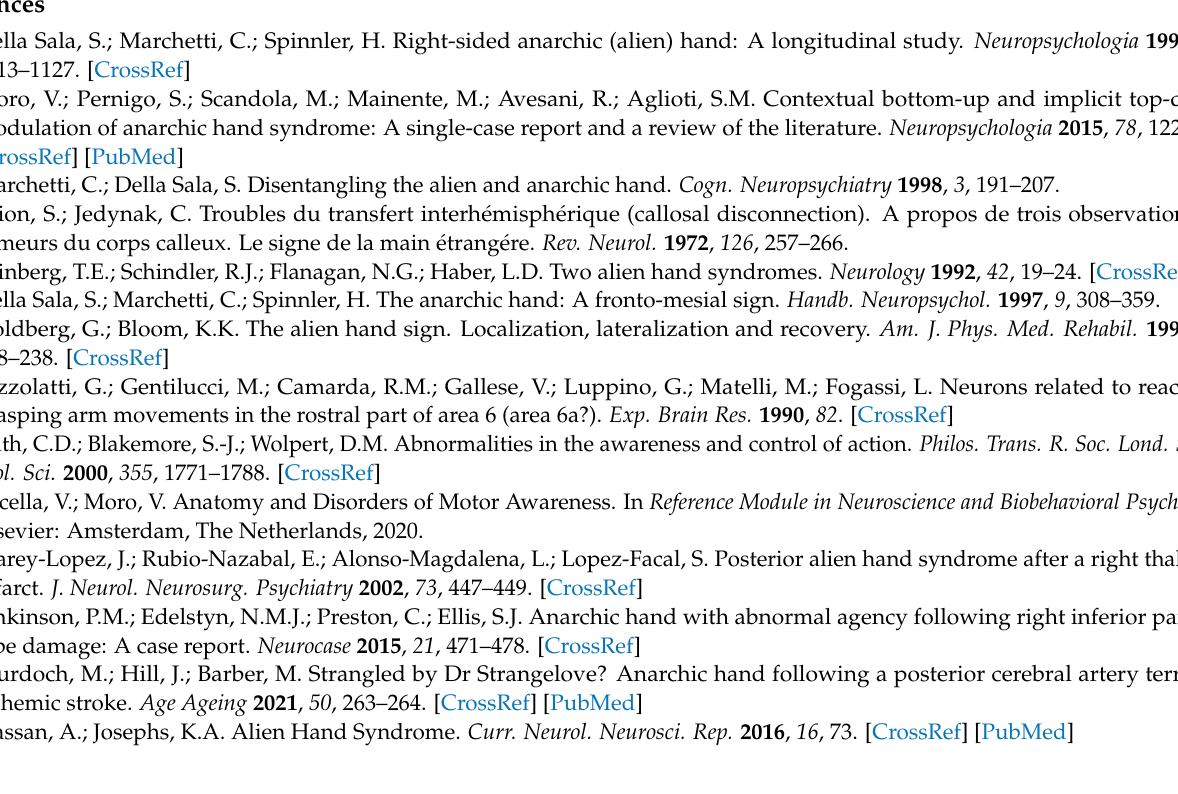
Table S11. Differences in frequencies of symptoms associated with Posterior left hemisphere damage or mixed (anterior and posterior) right anarchic hand in the patients analysed in the review of the